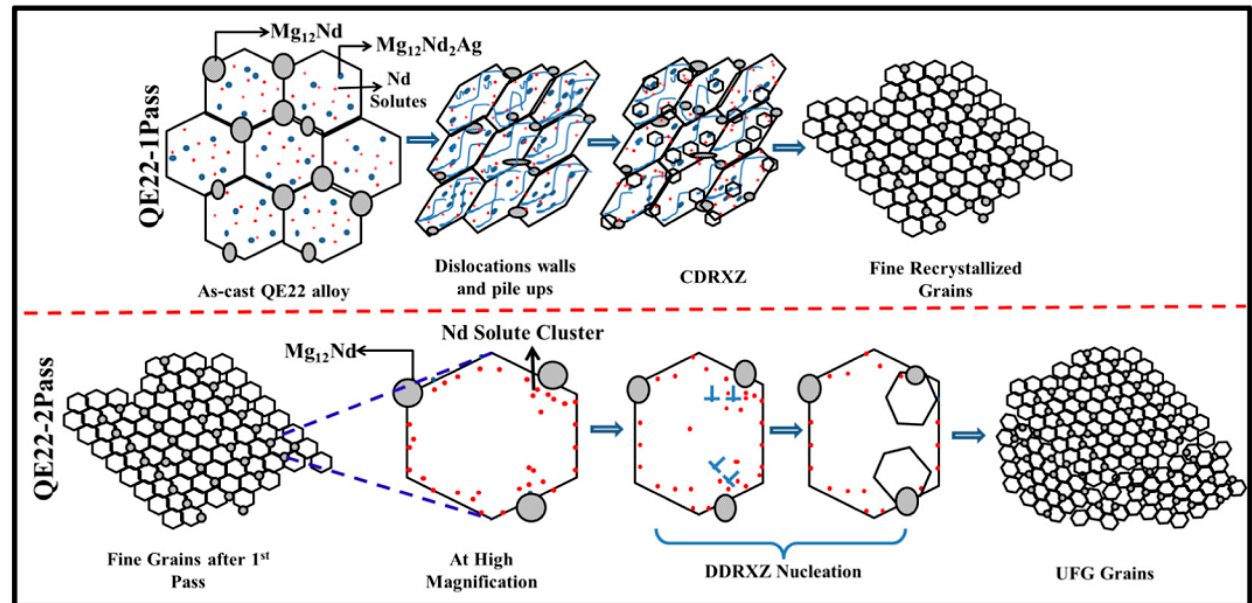
Figure 4. Schematic of the grain refinement process during FSP of the QE22 alloy (Reprinted with permission from ref. [99]. Copyright 2018 Elsevier Inc.).